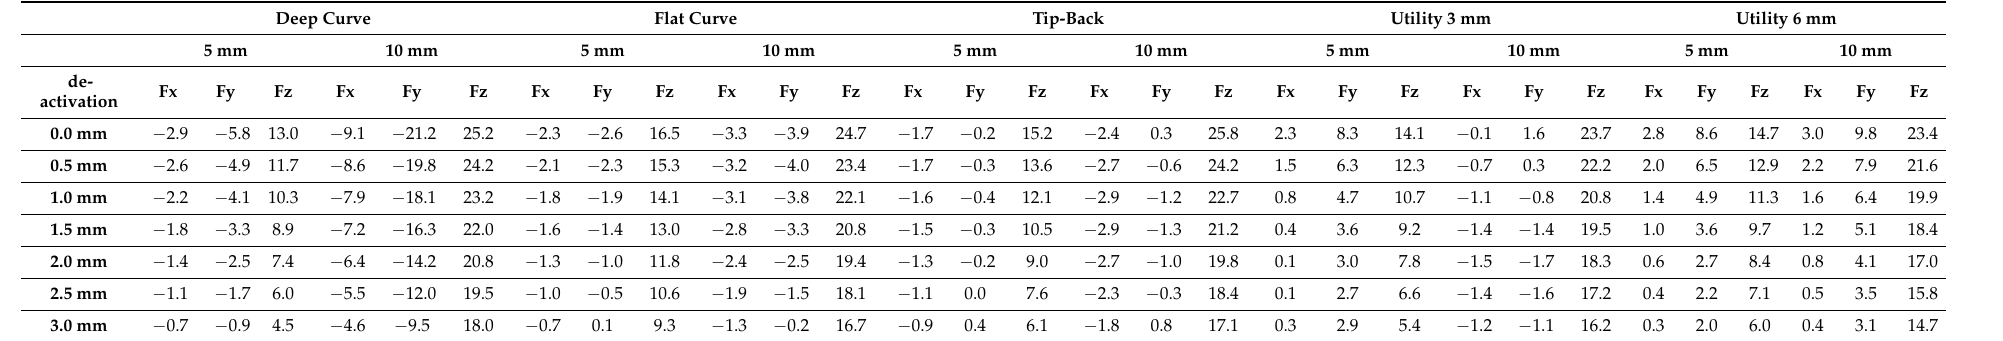
Table 3. Forces (cN) produced by the arch-formed cantilever configurations during deactivation.